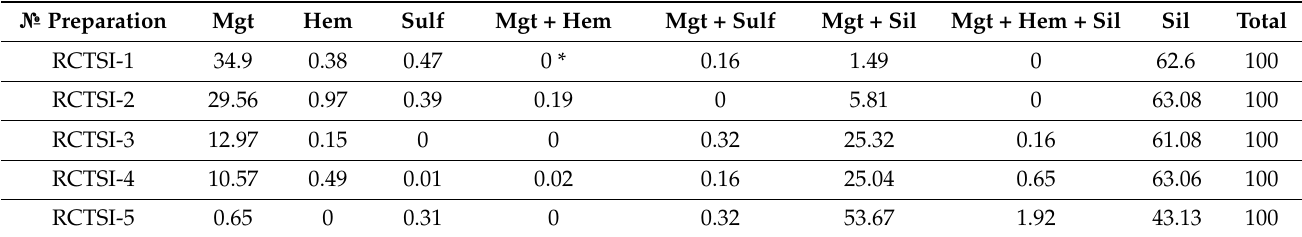
Table 10. Analysis of aggregates in the final product of crushing of samples